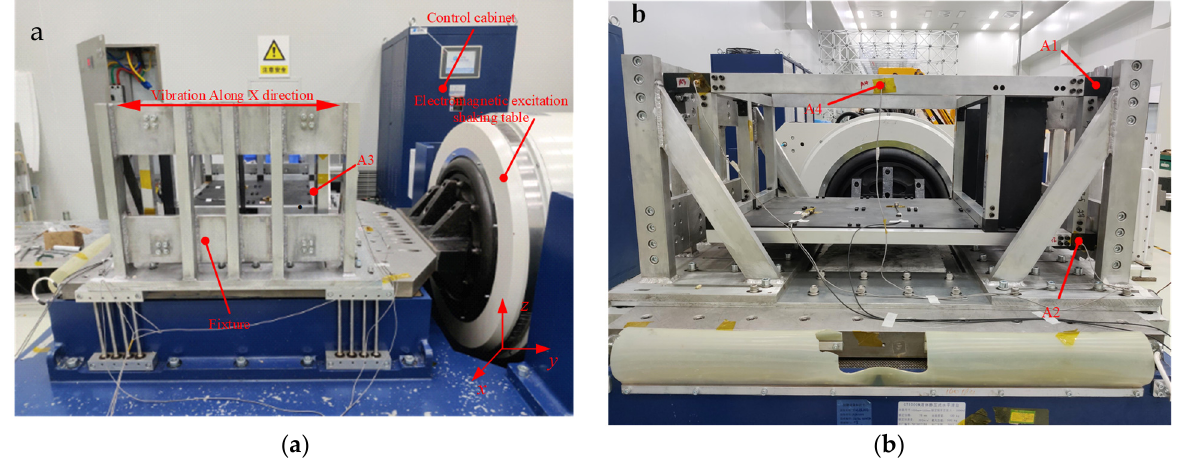
Figure 12. Test site of the experiment rack simulator. ( a ) Test rig. ( b ) Measured points’ layout. Table 7. Simulation and experimental vibration response under sweep